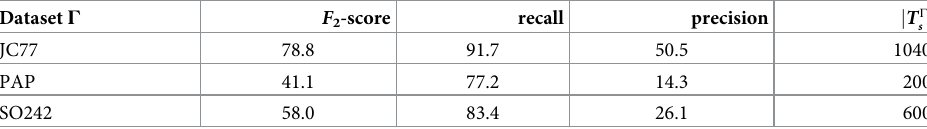
Table 1. Detection performance of the trained Mask R-CNN model on each validation subset V Γ